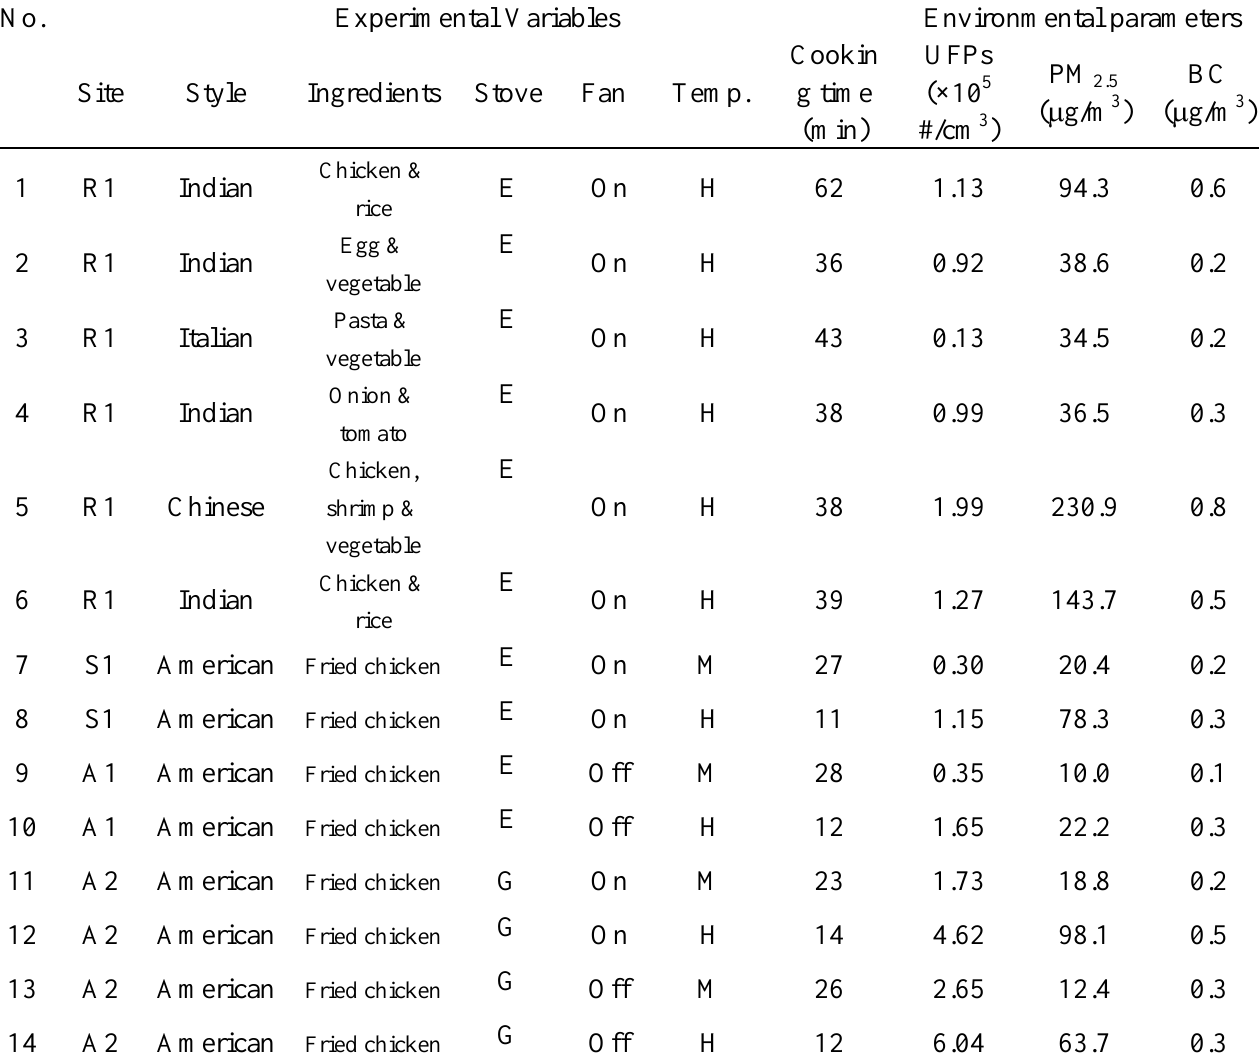
Table 1. Summary of average concentrations during cooking